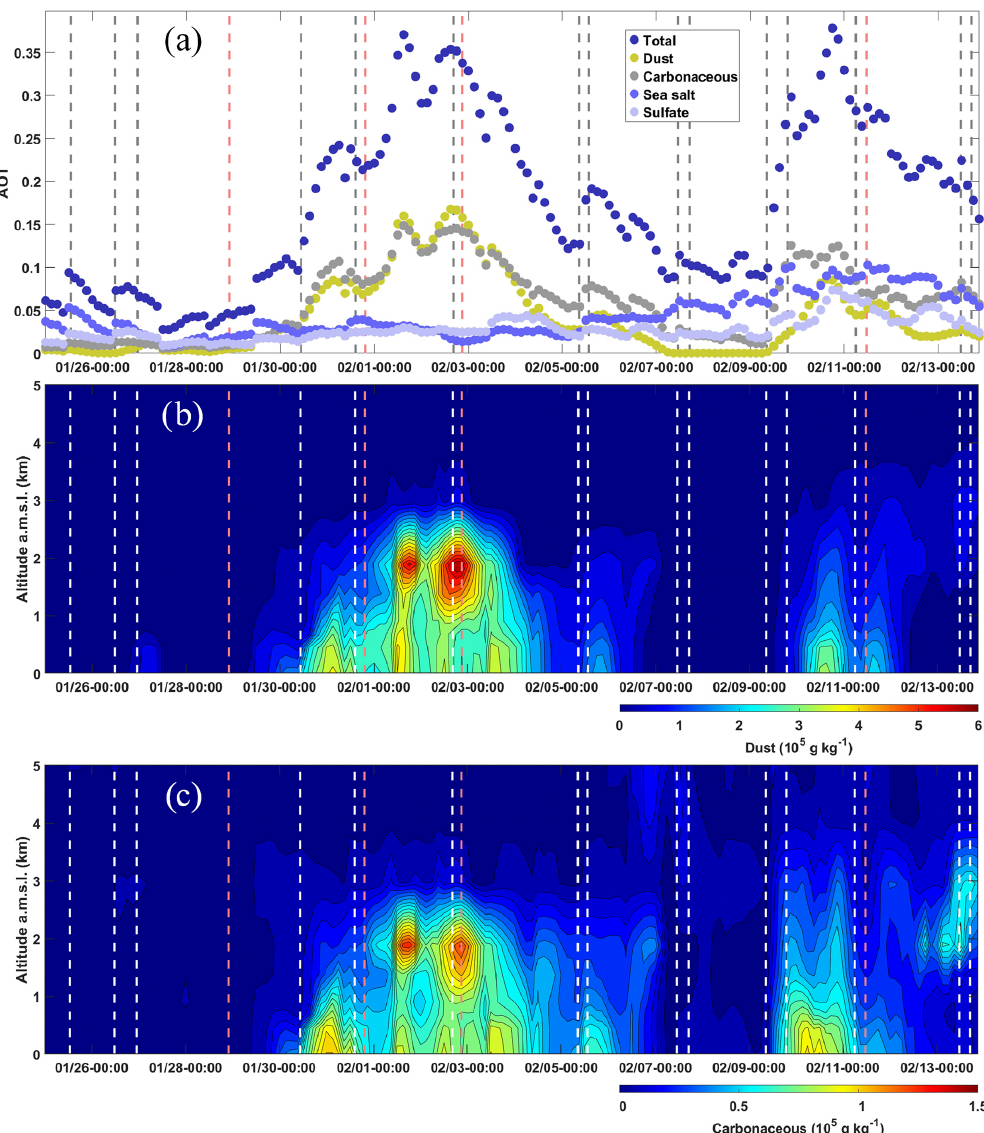
Figure 13. Temporal evolution derived from CAMS of (a) the aerosol optical thickness (AOT) at 550nm for different aerosol compounds, (b) the vertical profile of dust aerosol mass concentration, and (c) the vertical profile of carbonaceous (black carbon and organic carbon) aerosol mass concentration. The locations of the considered flight are highlighted by red vertical dotted lines. The other flights are highlighted by black–grey (white) vertical dotted lines in panel (a) ( b and c